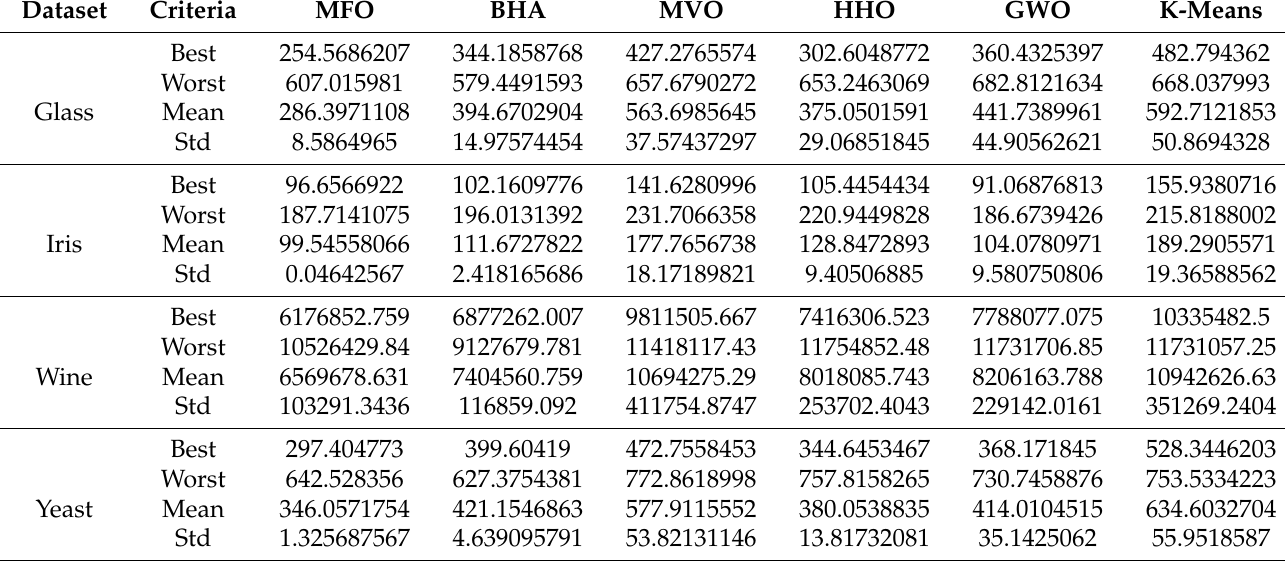
Table 4. Comparison of objective values of MFO, BHA, MVO, HHO, GWO, k-means algorithms.